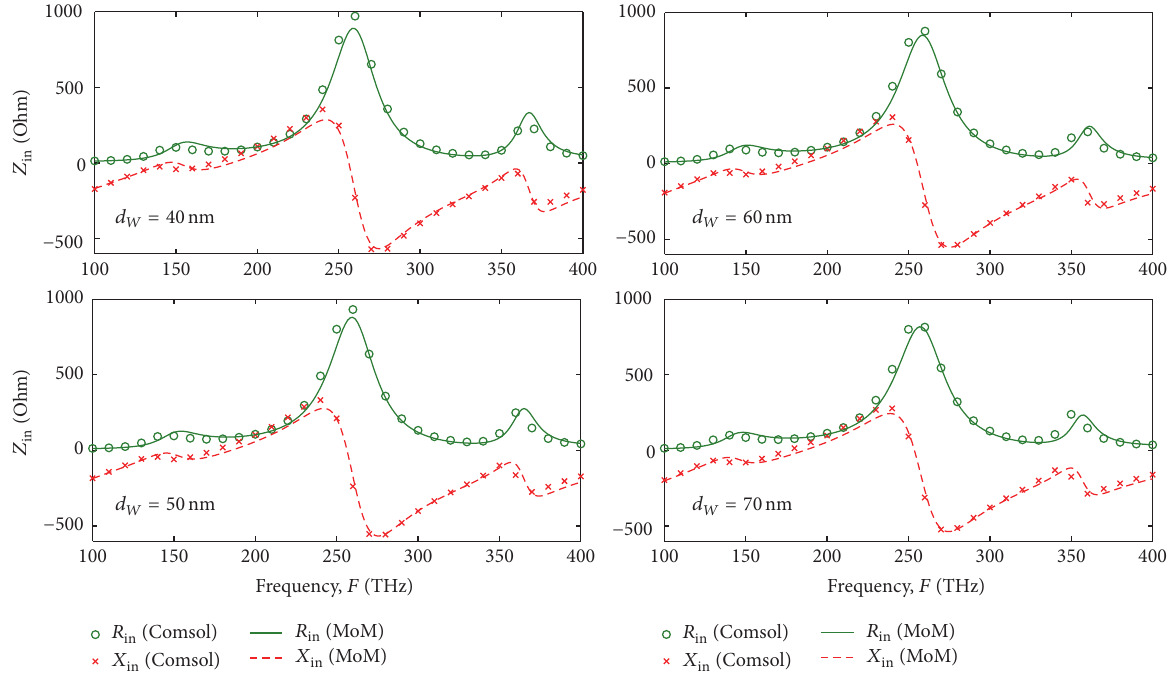
Figure 12: Input impedance of the composed nanoantenna for 𝑑 𝑊 = 40, 50, 60, and 70 nm and 𝑑 𝐻 = 20 nm.